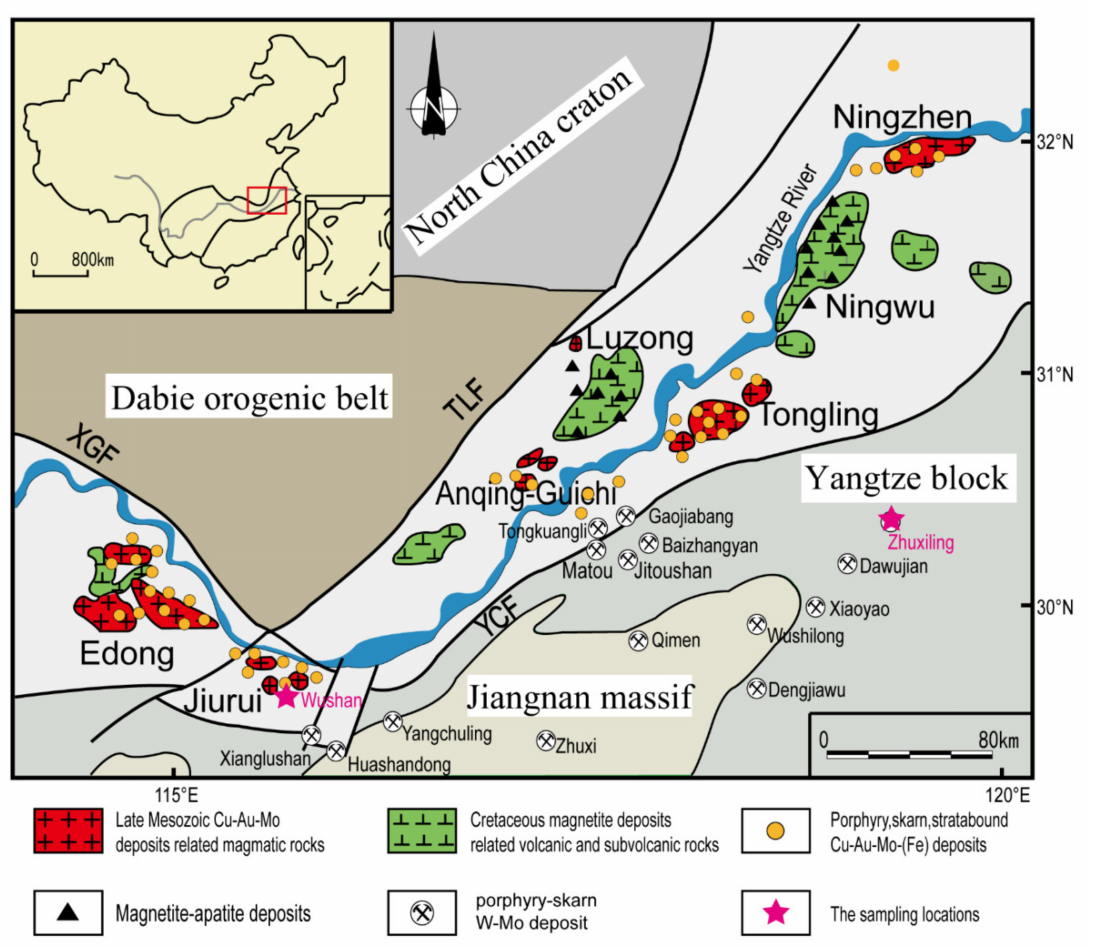
Figure 1. Geological sketch map for the Jiangnan tungsten ore belt showing the location of the Zhuxiling W (Mo) deposit (after